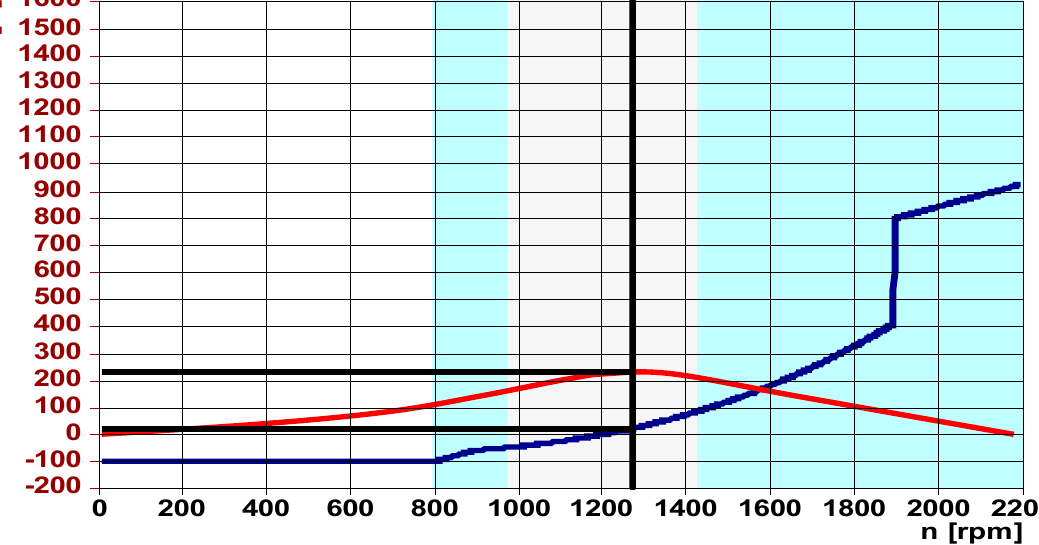
Figure 17. A wind turbine based on DFIG with a speed of 6.5 m/s.